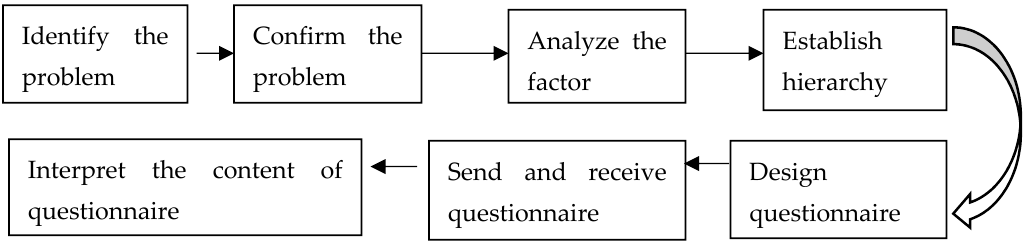
Figure 1. The steps of the analytic hierarchy process (AHP).